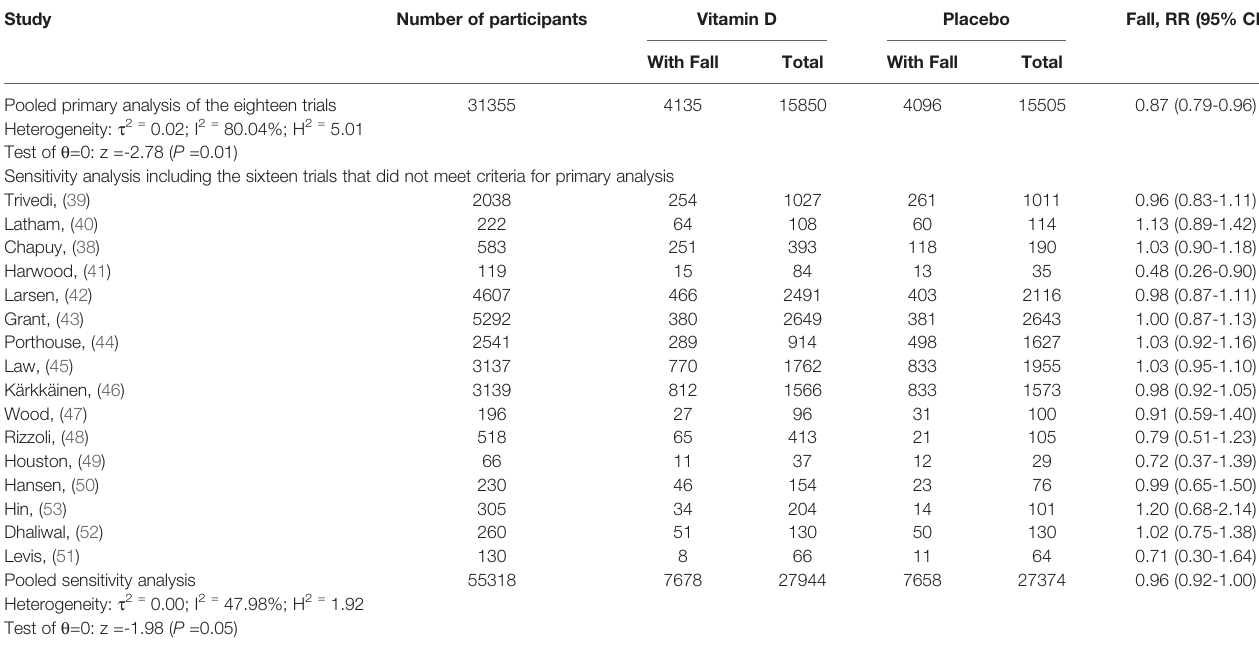
Study Number of participants